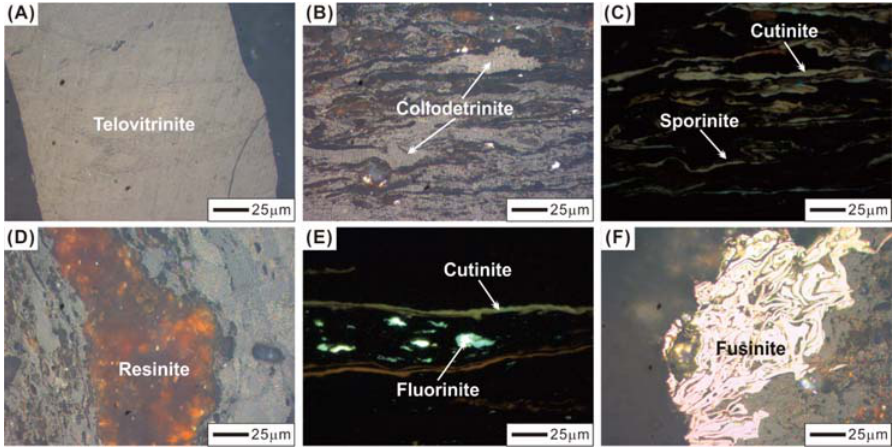
Figure 4. Representative photomicrographs of oil shale and coal (oil immersion). ( A ) Telovitrinite (incident white light). ( B ) Collodetrinite (incident white light). ( C ) The same area of Figure 4B, revealing sporinite and cutinite (blue-light irradiation). ( D ) Resinite with orange internal reflection (incident white light). ( E ) Cutinite with fluorinite in between (blue-light irradiation). ( F ) Pyrofusinite (incident white light).